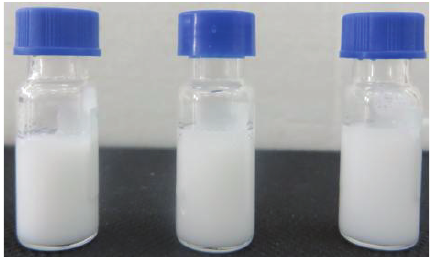
Figure 2: Photograph of sinomenine cubosome.